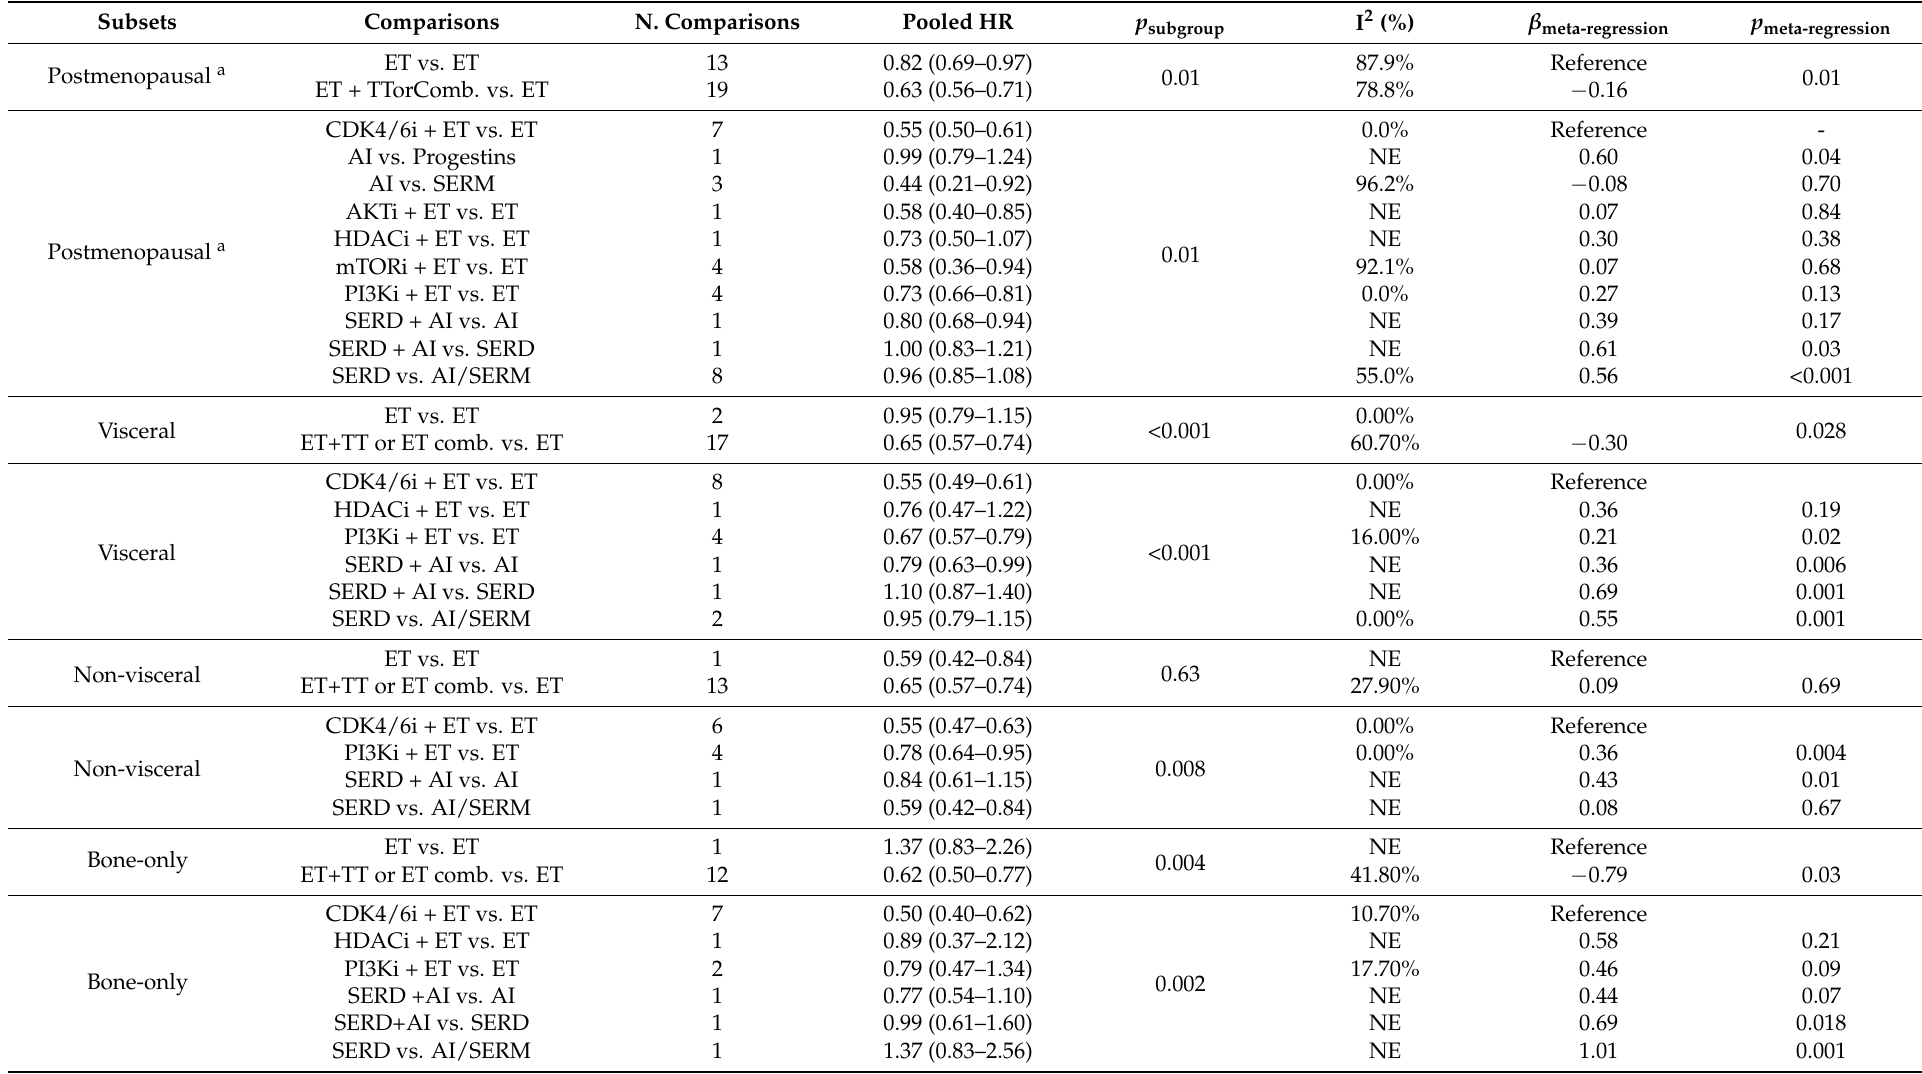
Table 2. The results of PFS/TTP subgroup analyses and meta-regressions for treatment categories and drug classes.